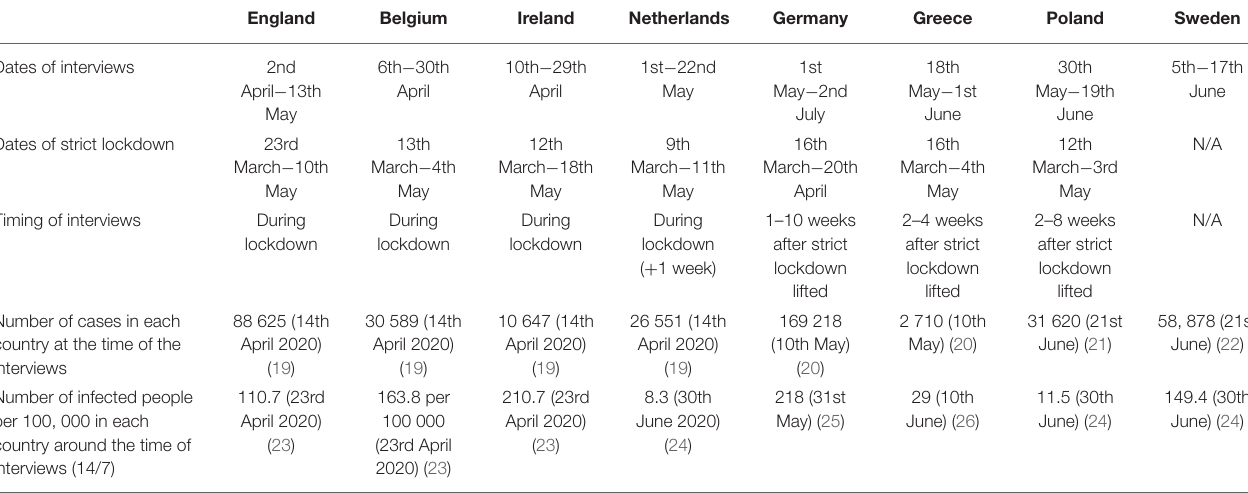
TABLE 2 | Timing of interviews and contextual information by